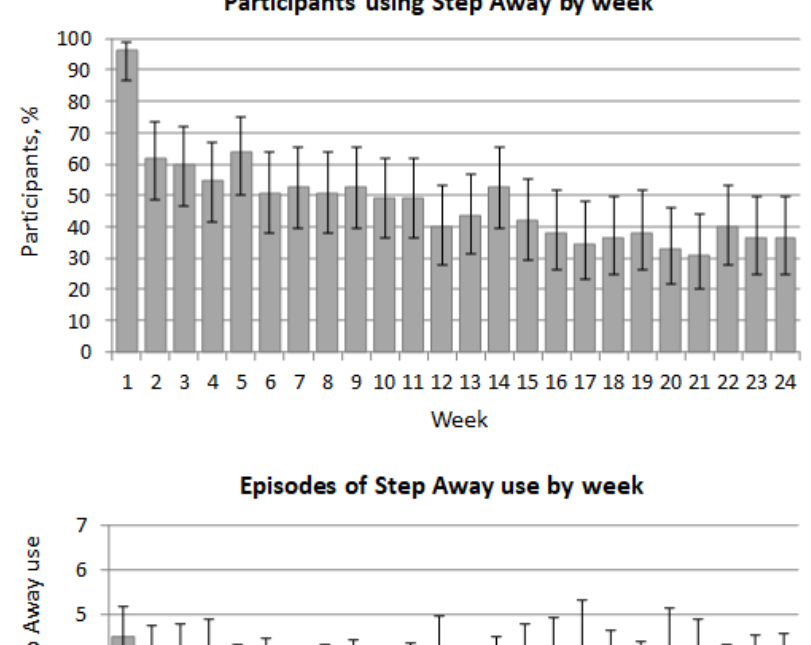
Figure 2. Step Away app engagement by week. App users are defined as study participants who used the app in a given